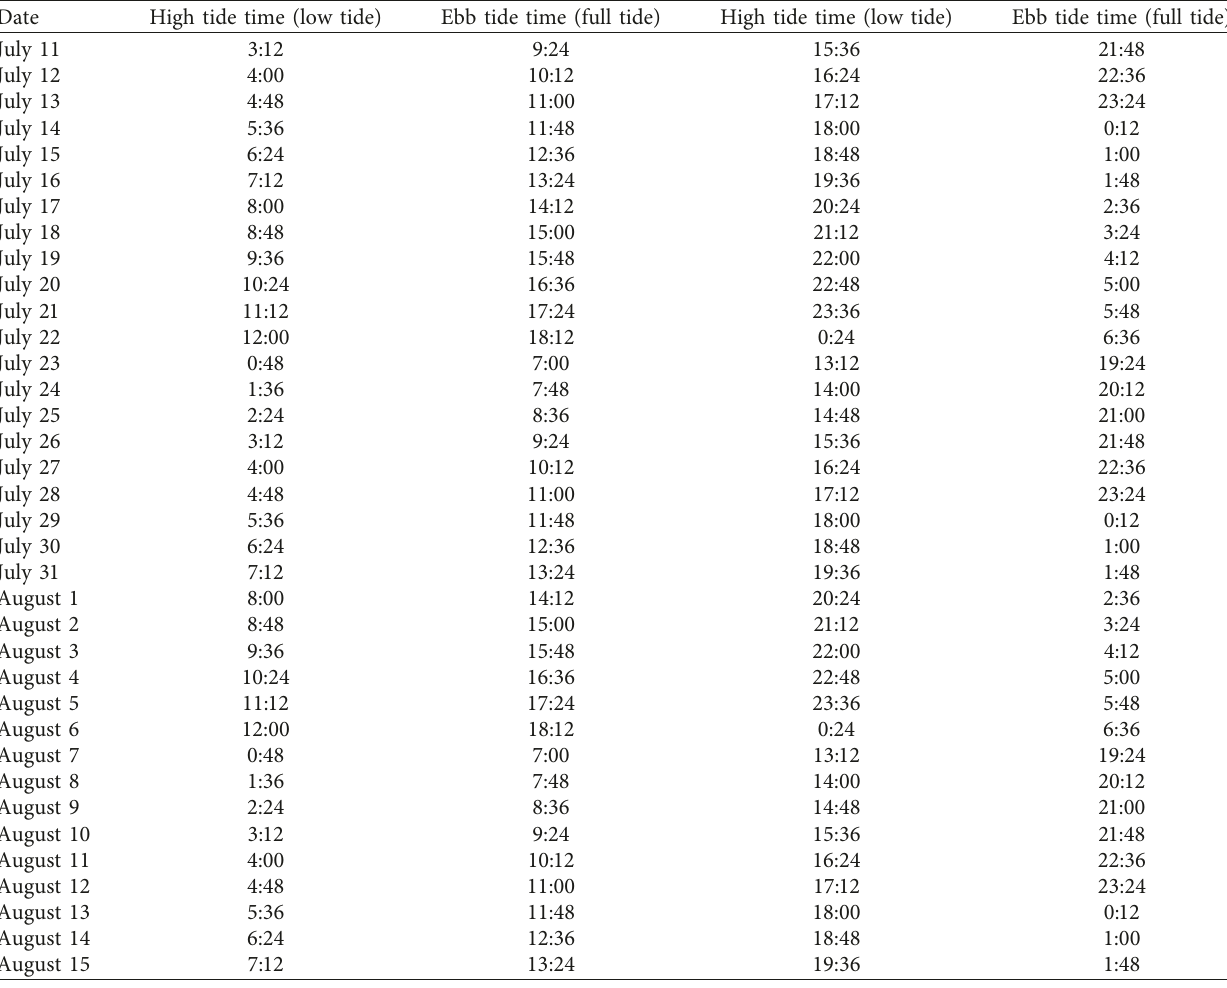
Table 4: Tidal data in the experimental sea